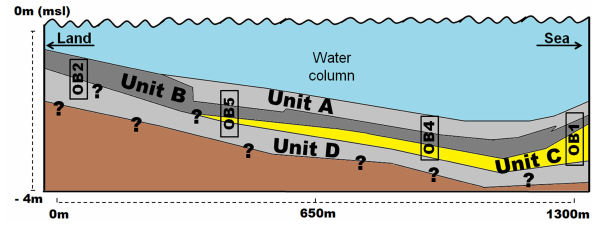
Fig. 5. Schematic stratigraphic profile (including cores OB1; OB4; OB5 and OB2) based in the lithostratigraphy of Lagoa de ´Obidos (for core locations please check Fig. 1e).